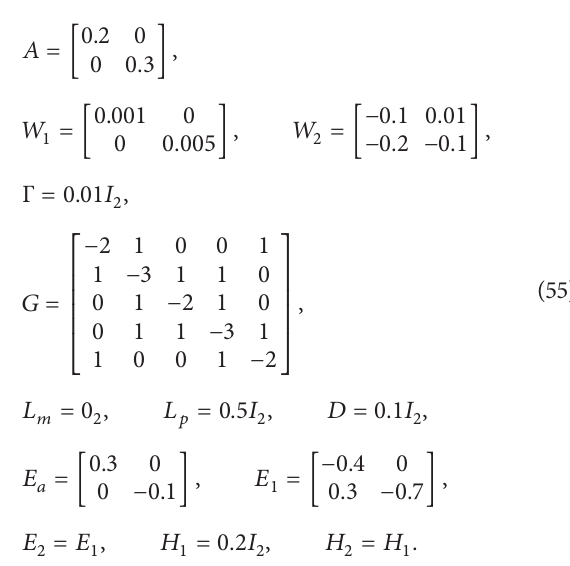
Table 1: Maximum allowable delay bounds, ℎ 𝑀 , with different ℎ 𝑚 and fixed 𝜏 = 3 (Example 10).